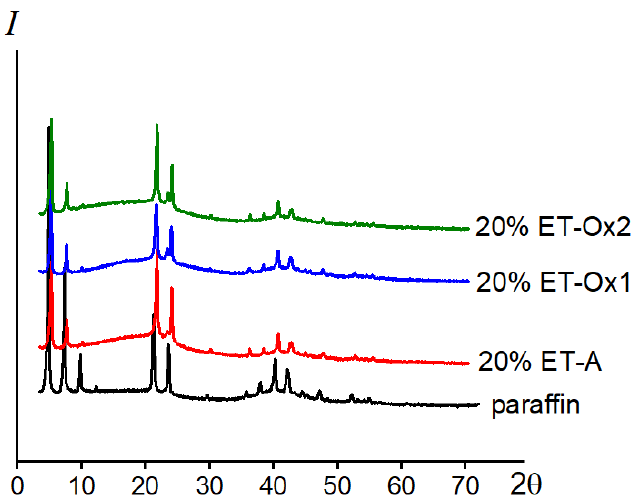
Figure 7. X ‐ ray diffraction patterns of systems based on paraffin (1) and its composites containing 20 wt. % asphaltenes ET ‐ A (2), ET ‐ Ox1 (3), ET ‐ Ox2 (4), T = 25°C .